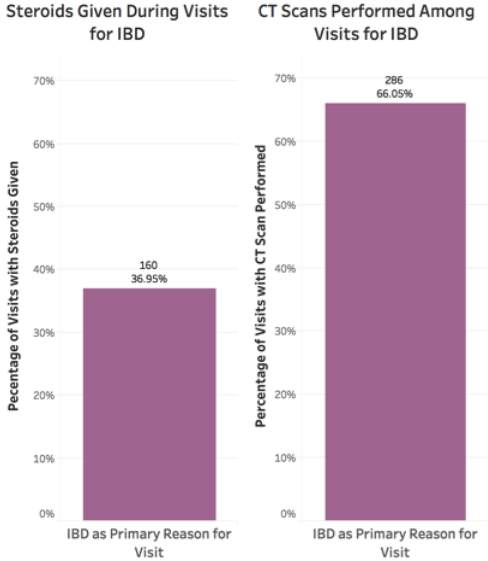
Figure 6. Percentage of visits with steroids given or CT scans performed in visits with IBD as the primary reason for the visit. Steroid use was also more common in those with IBD as the primary reason for the ED visit ( p ≤ 2.2 × 10 − 16 , coefficient 0.228). There was an increased risk of CT scan when the primary reason for the visit was for IBD ( p ≤ 2.2 × 10 − 16 , coefficient 0.372).